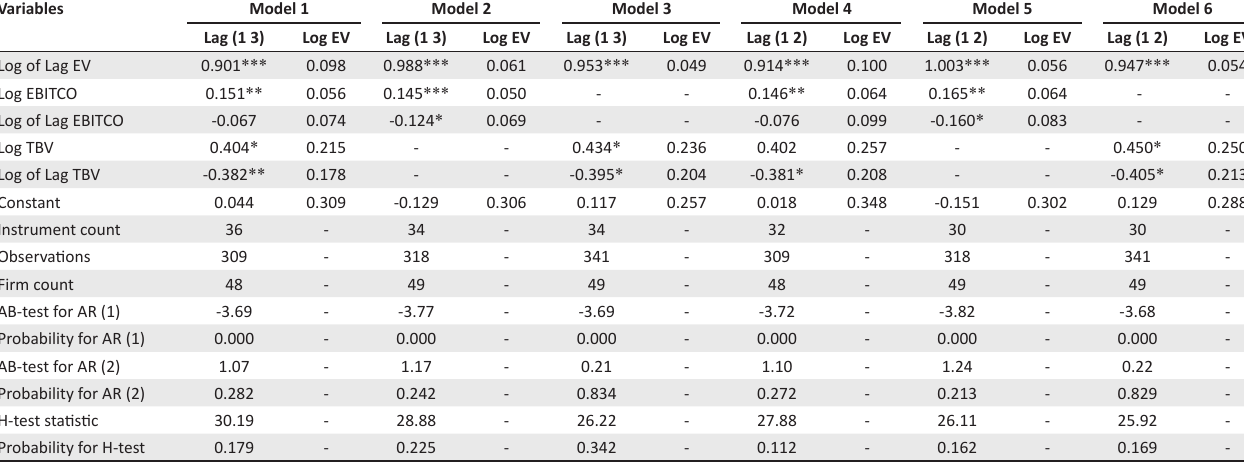
TABLE 5: Regression results (Log EV as response variable).